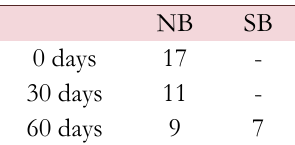
Table 2: Number of valid specimens of fatigue